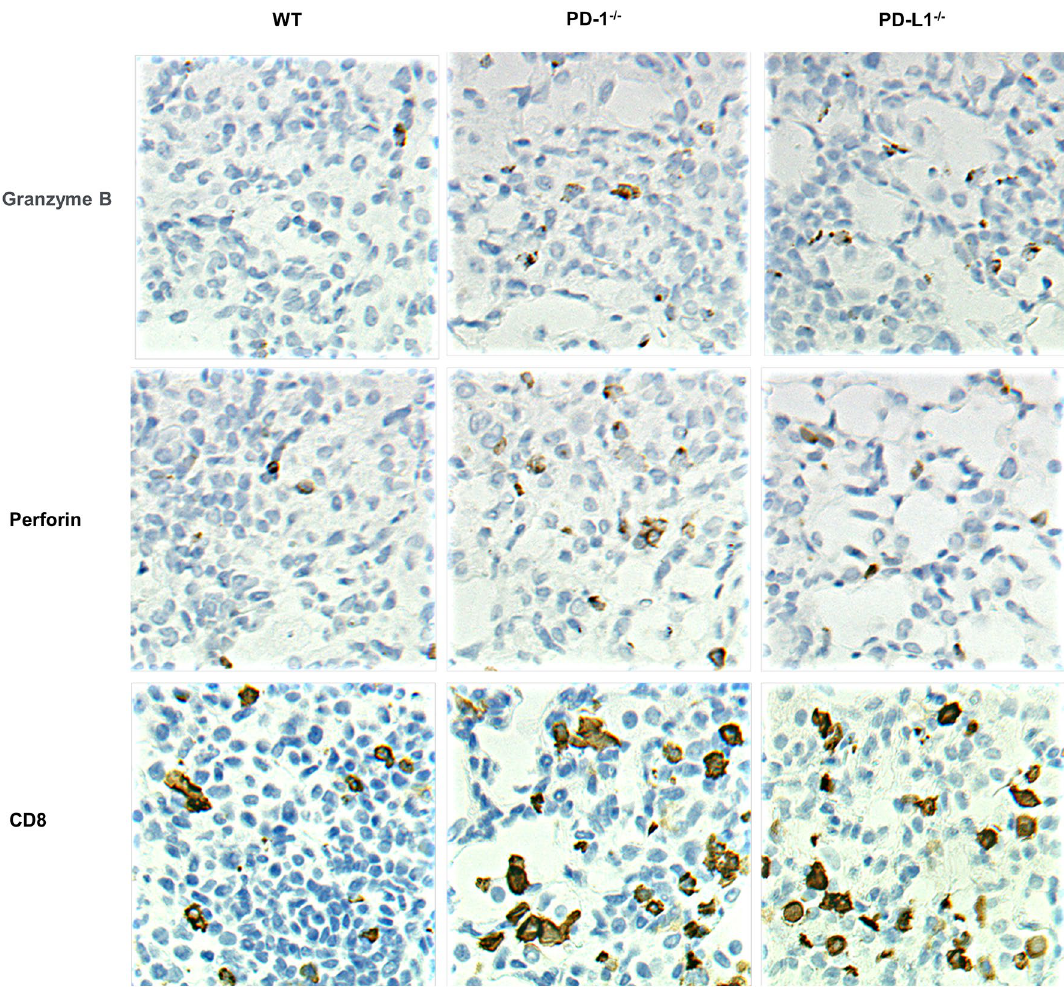
Figure 5. Pathogenic role of CD8-positive T cells in the lungs after MAC infection. Representative photographs of immunostaining for CD8, granzyme B, and perforin in the lungs of wild-type, PD-1 −/− , and PD-L1 −/− mice 60 days after MAC infection (× 400).